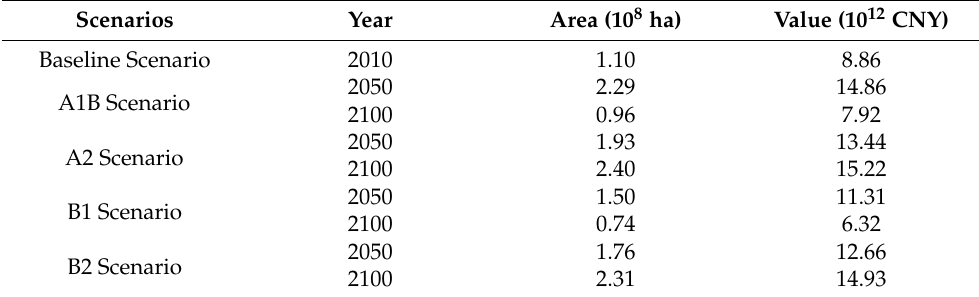
Table 4. Change in farmland area and value in China under different scenarios